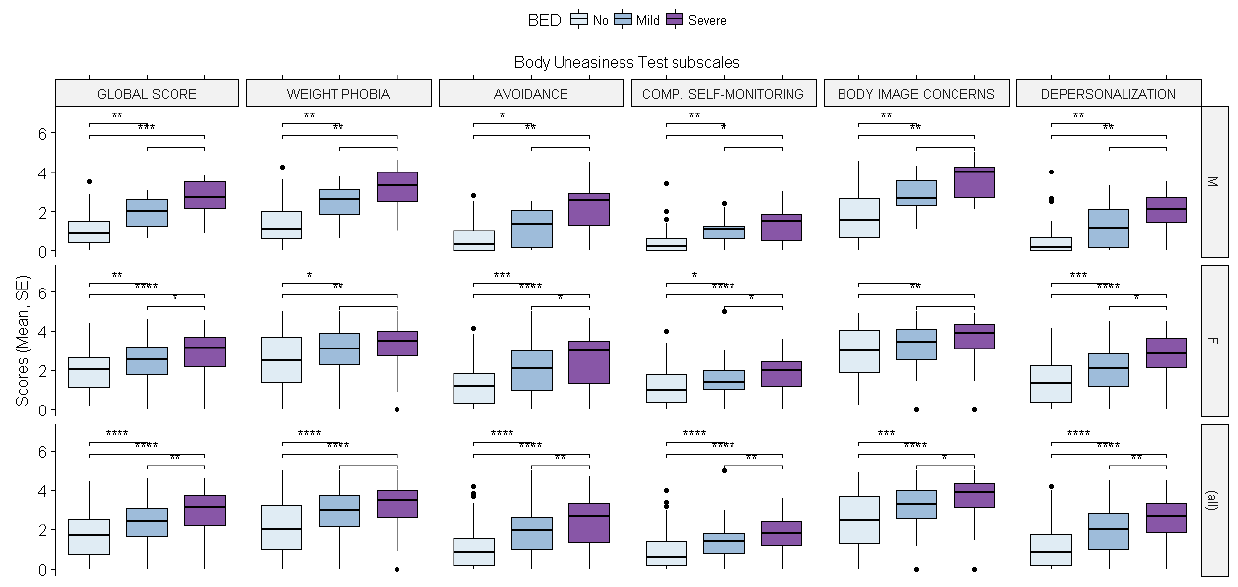
Figure 6. The effects of binge eating disorder severity and gender on the scores for the Body Uneasiness Test. The differences between the groups were evaluated using the Wilcoxon test: avoidance (severe: ß = 1.624, p = 0.0003; female: ß = 0.762, p = 0.0002); body image concerns (severe: ß = 1.854, p = 0.0001; mild to moderate: ß = 1.022, p = 0.0032; female: ß = 1.081, p = 0.00001); compulsive self‐monitoring (severe: ß = 0.909, p = 0.0084; mild to moderate: ß = 0.572, p = 0.0277; female: ß = 0.694, p = 0.00001); depersonalization (severe: ß = 1.384, p = 0.0011; mild to moderate: ß = 0.843, p = 0.0084; female: ß = 0.902, p = 0.00001); weight phobia (severe: ß = 1.724, p = 0.0002; mild to moderate: ß = 0.995, p = 0.0042; female: ß = 1.083, p = 0.00001). * = p < 0.05; ** = p < 0.01; *** = p < 0.001; **** = p < 0.000.